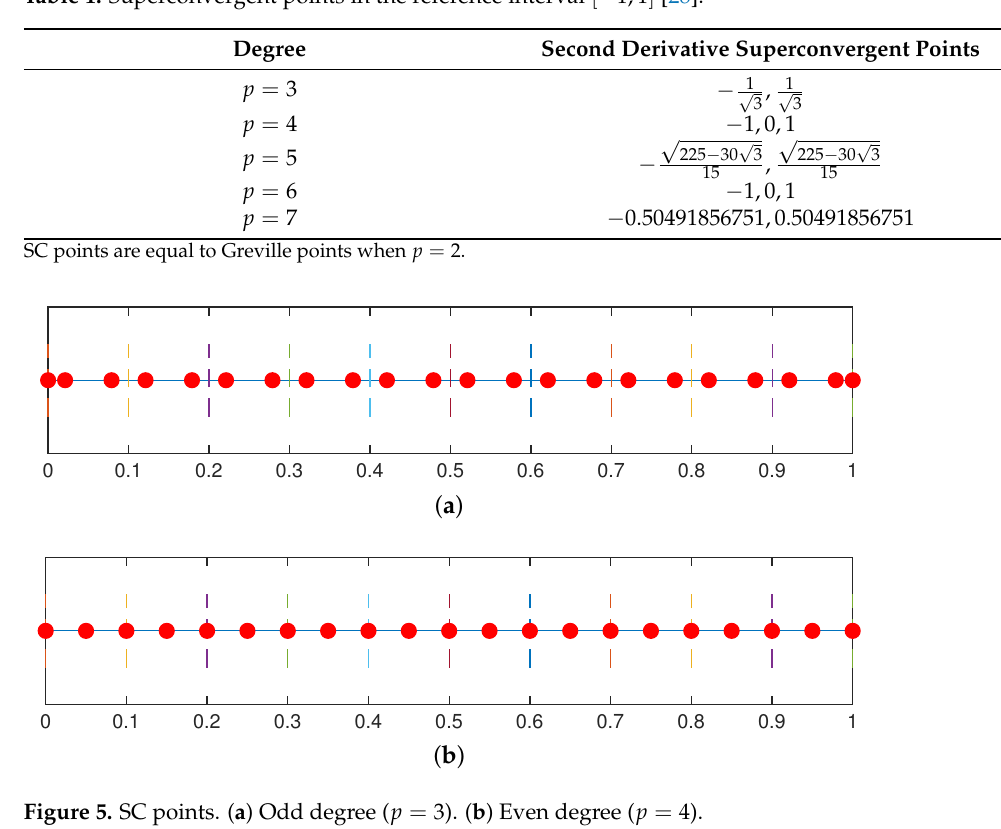
Figure 5. SC points. ( a ) Odd degree ( p = 3). ( b ) Even degree ( p =